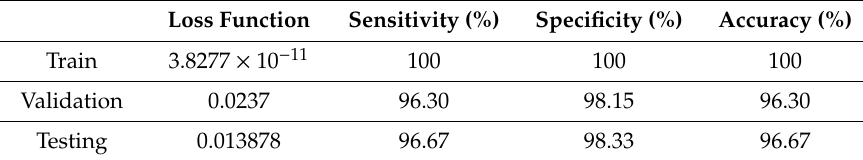
Figure 3. Simulation results of loss function and accuracy. Table 2. Simulation results.